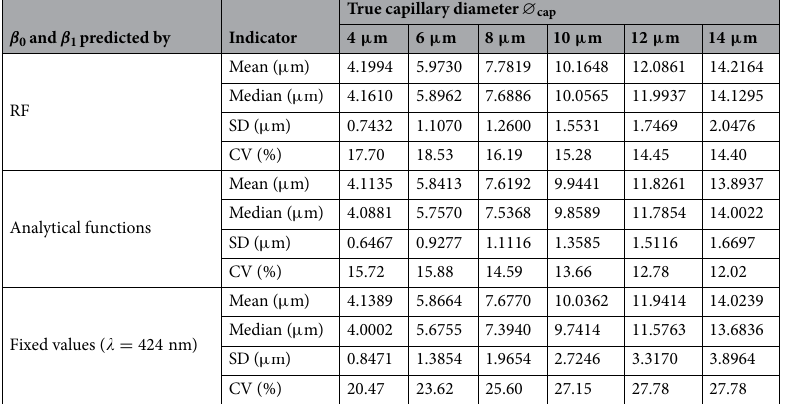
β 0 and β 1 predicted